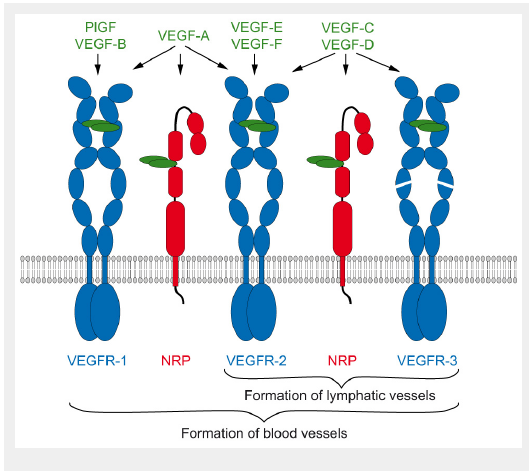
VEGFs and their interactions with VEGFRs and NRPs. The human genome encodes five VEGF genes (A, B, C, D, and PlGF). Two VEGFs are encoded by viruses (E) and snakes (F), respectively. They all exist as dimers and induce dimerisation of the VEGFRs upon binding. Their binding specificity to the three VEGFRs and NRPs is indicated by